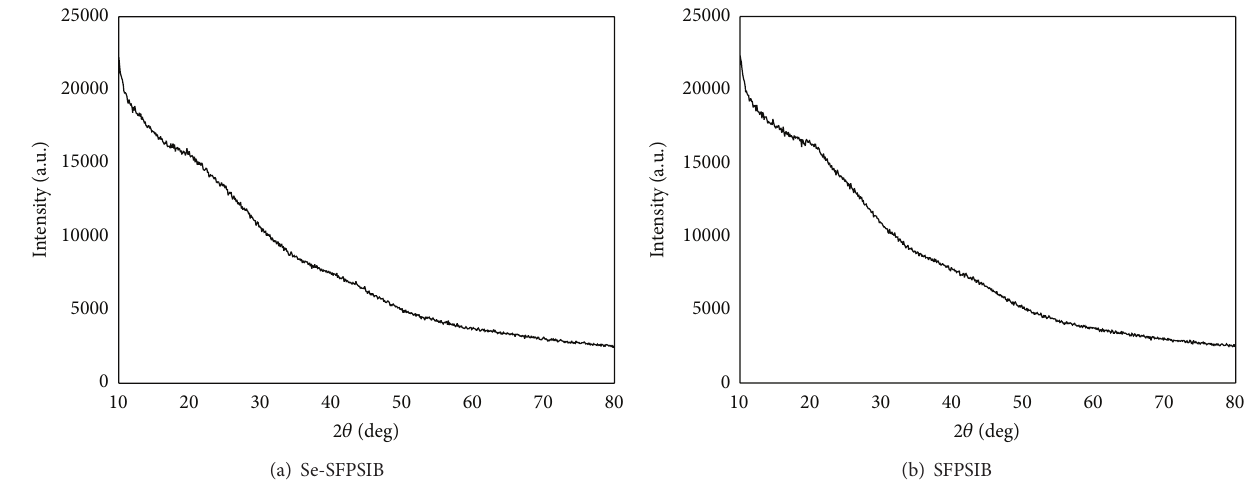
Figure 7: X-ray diffraction curves recorded for (a) Se-SFPSIB and (b) SFPSIB.